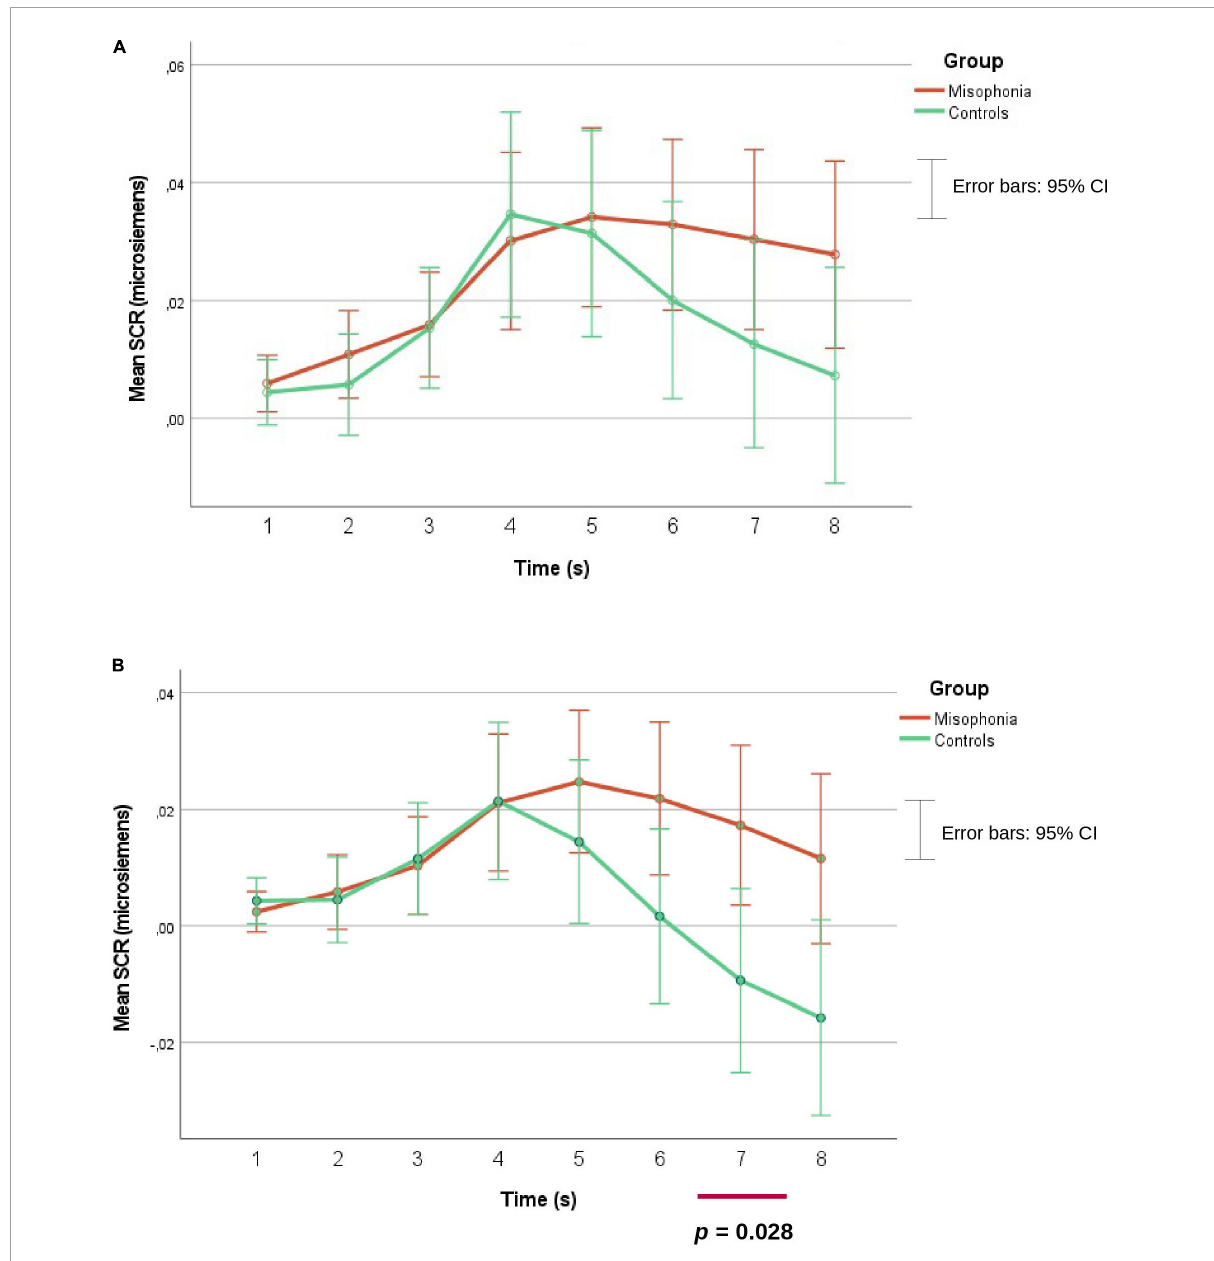
FIGURE5 SCR means separately for misophonia and controls, and for two separate analyses (A,B) .